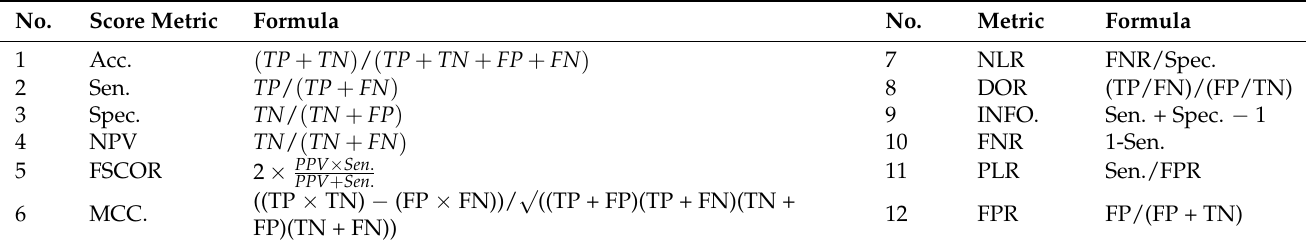
Table 5. Summary description of performance evaluation